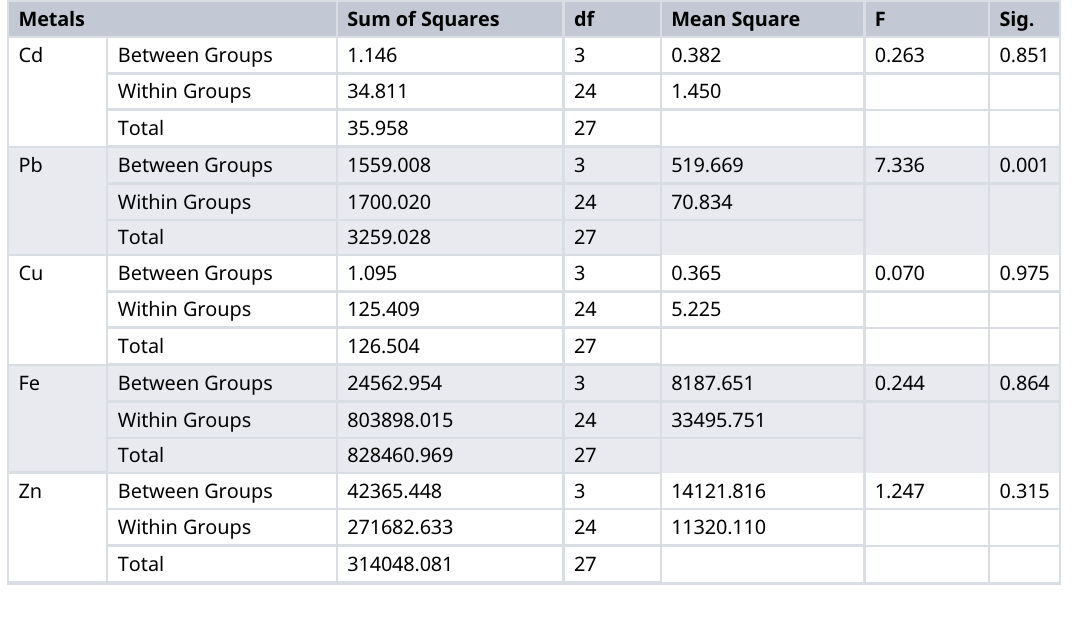
Table 2. Anova test of heavy metal concentration on Caulerpa racemosa in different